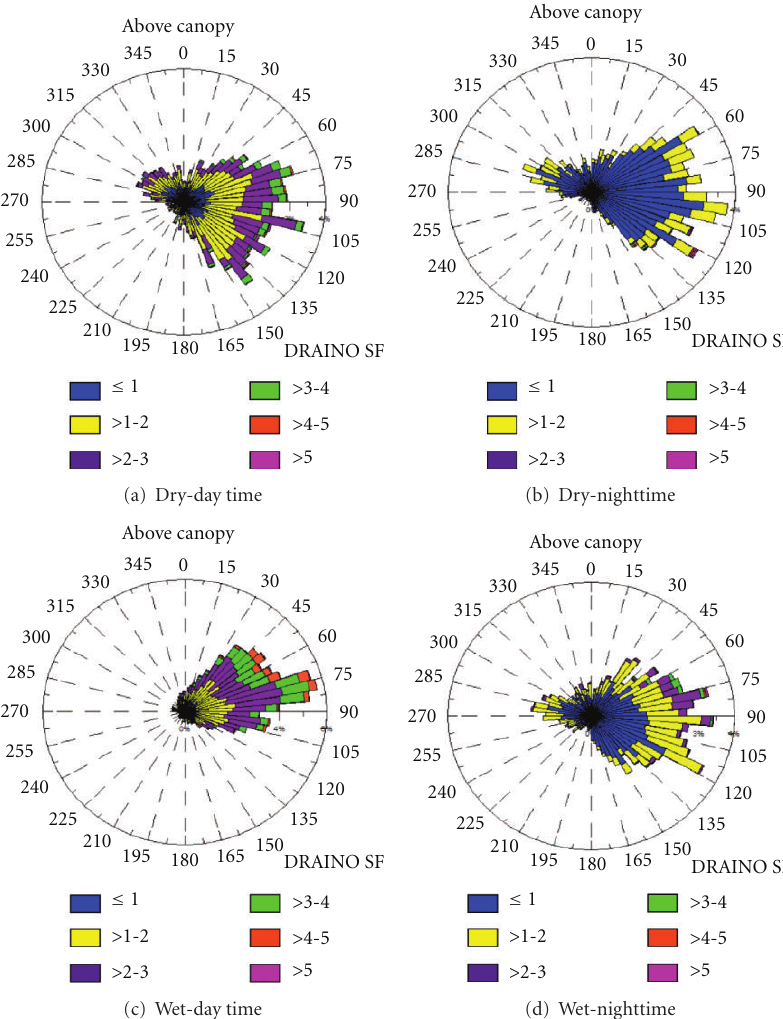
Figure 11: Frequency distribution of the wind speed and direction above canopy (38m above ground level-a.g.l). For dry ((a), (b)) and wet ((c), (d)) periods from the year 2006 during day ((a), (c)) and nighttime ((b), (d)), on the slope area at DRAINO system tower.